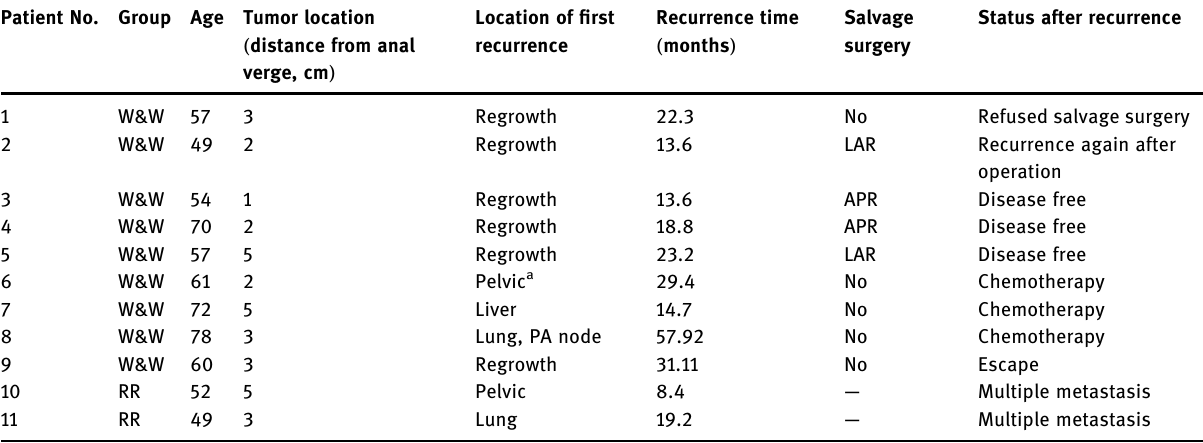
Table 2: Recurrence data Patient No. Group Age Tumor location ( distance from anal